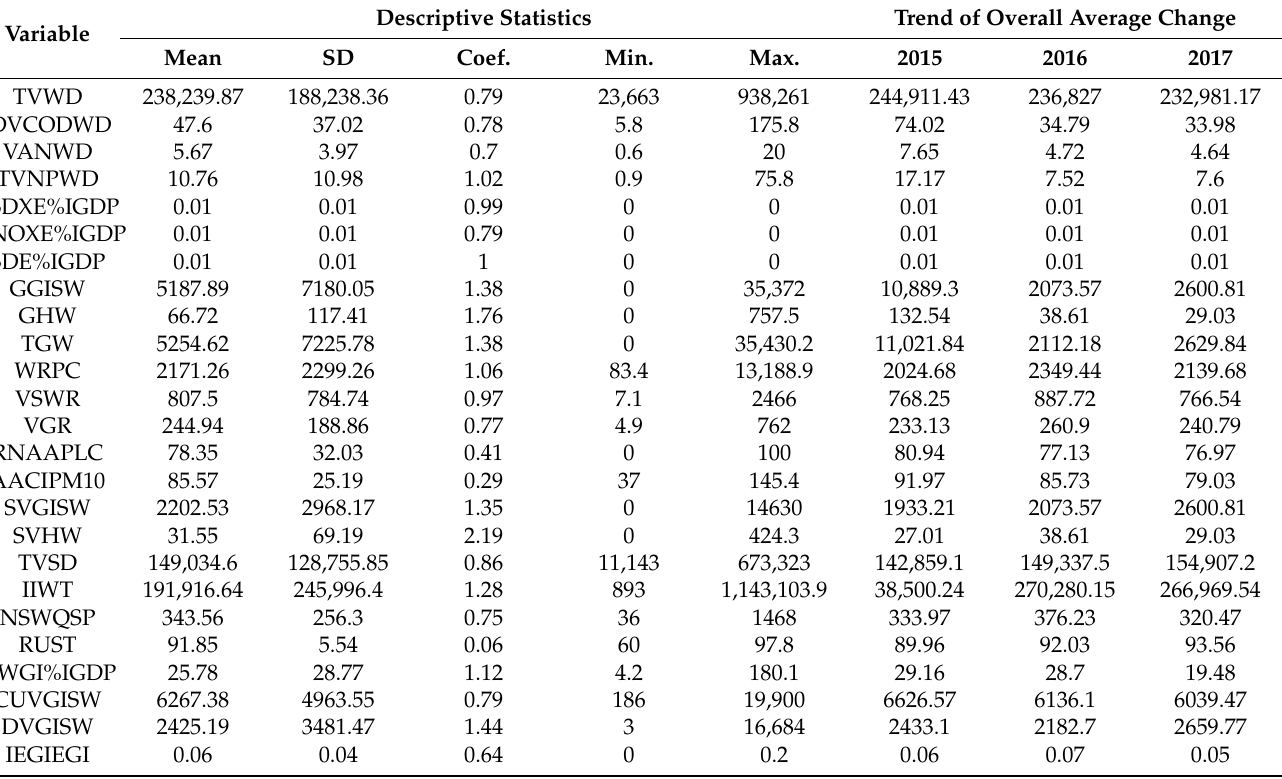
Table 4. Descriptive Statistics of Variables.